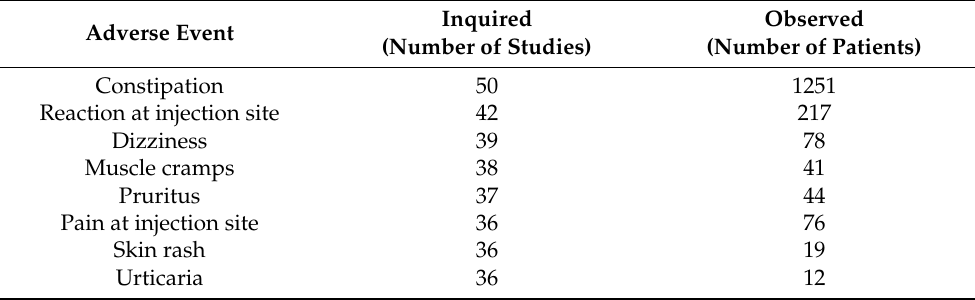
Table 2. Most frequent adverse events reported in clinic-based